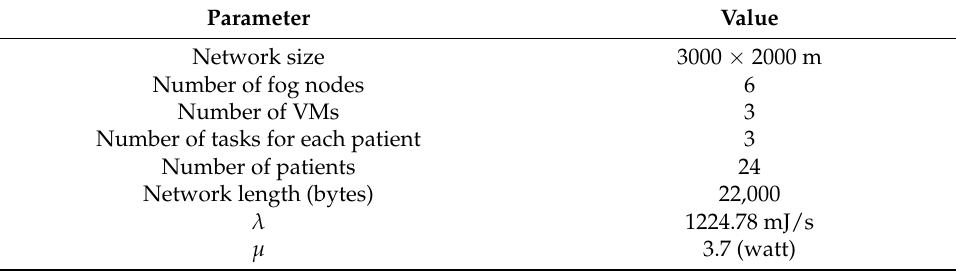
Table 5. Value of parameters used in proposed EEIoMT